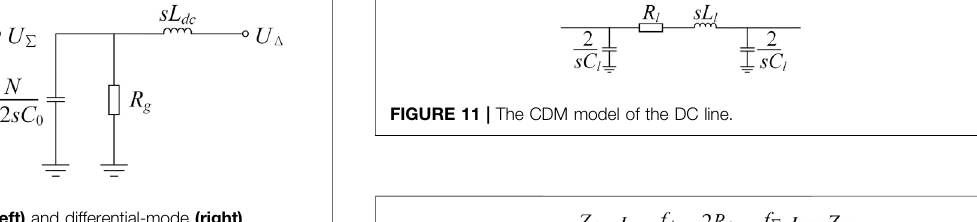
FIGURE 8 | The common-mode (left) and differential-mode (right) models of the converter in case 2.